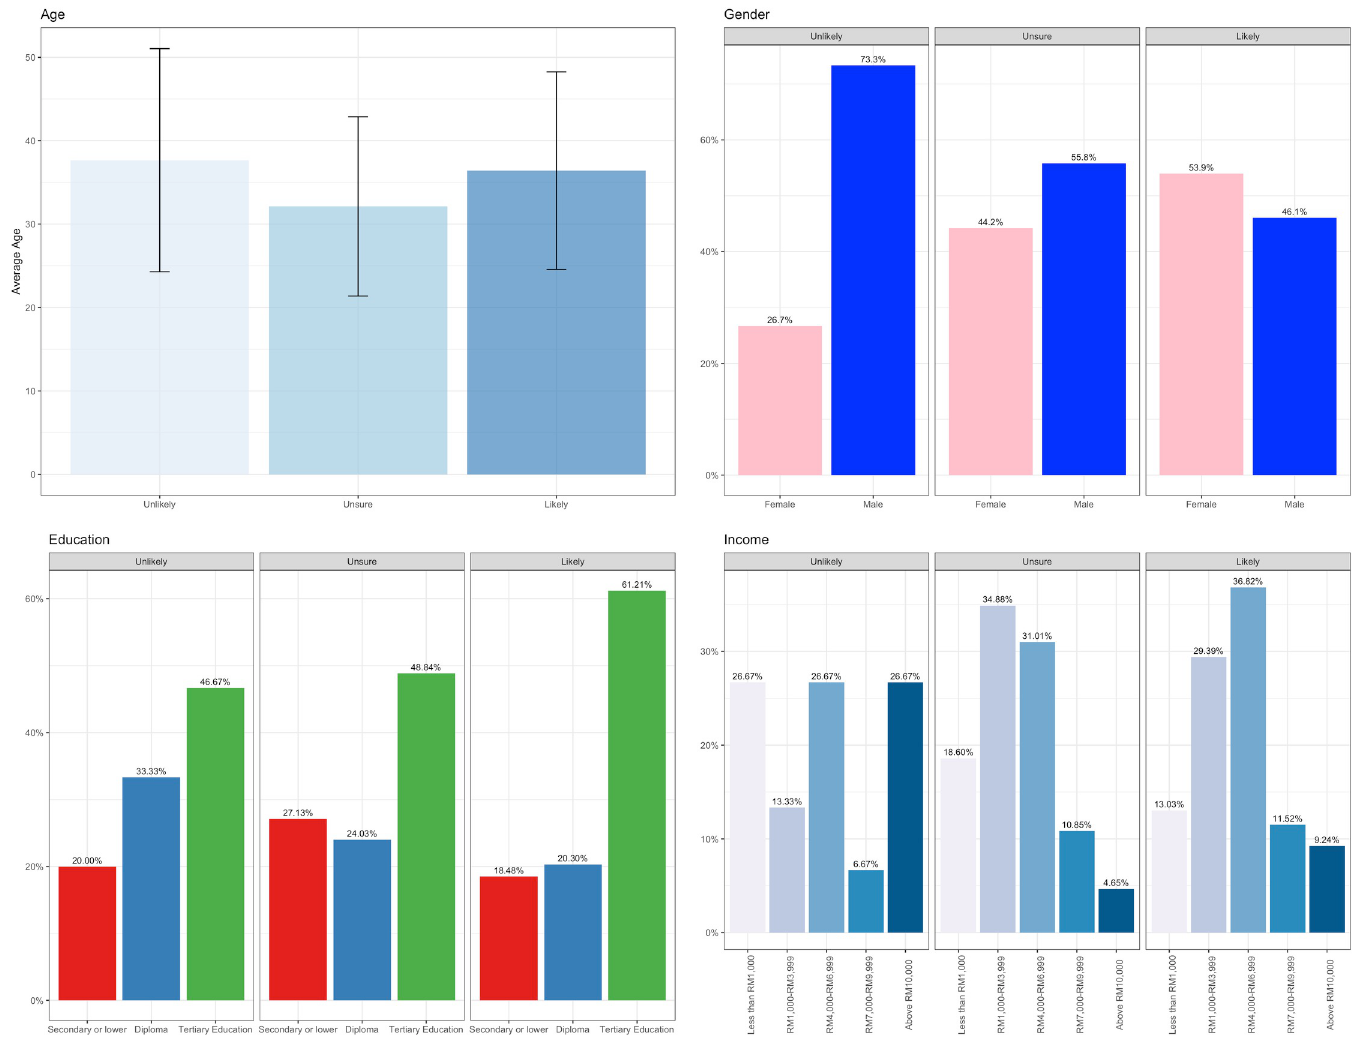
Fig 1. Demographic of respondents according to vaccination